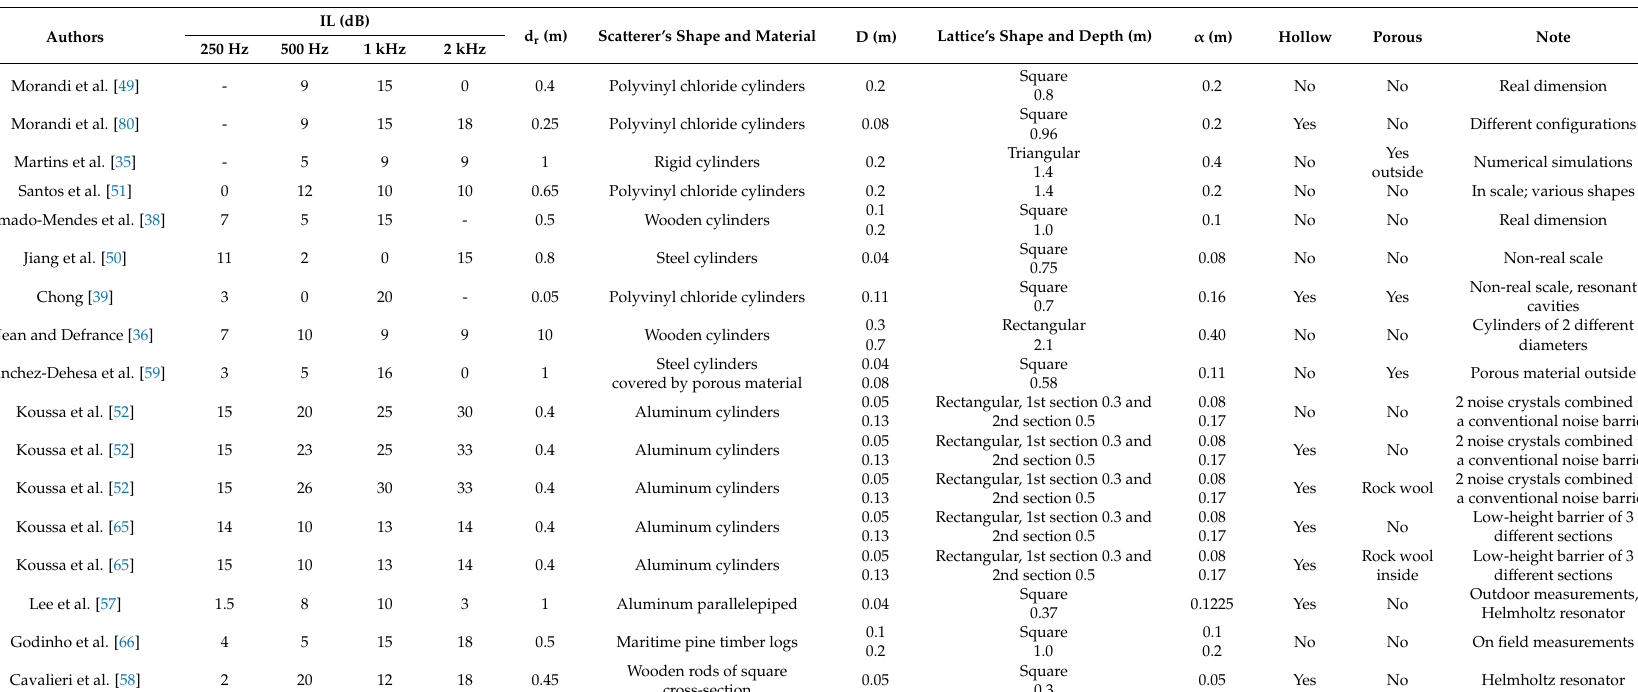
Table 1. Comparative analysis of insertion loss (IL) obtained in different studies. d r is the distance of IL evaluation from the barrier, D is the scatterer diameter (or side), and α is the lattice